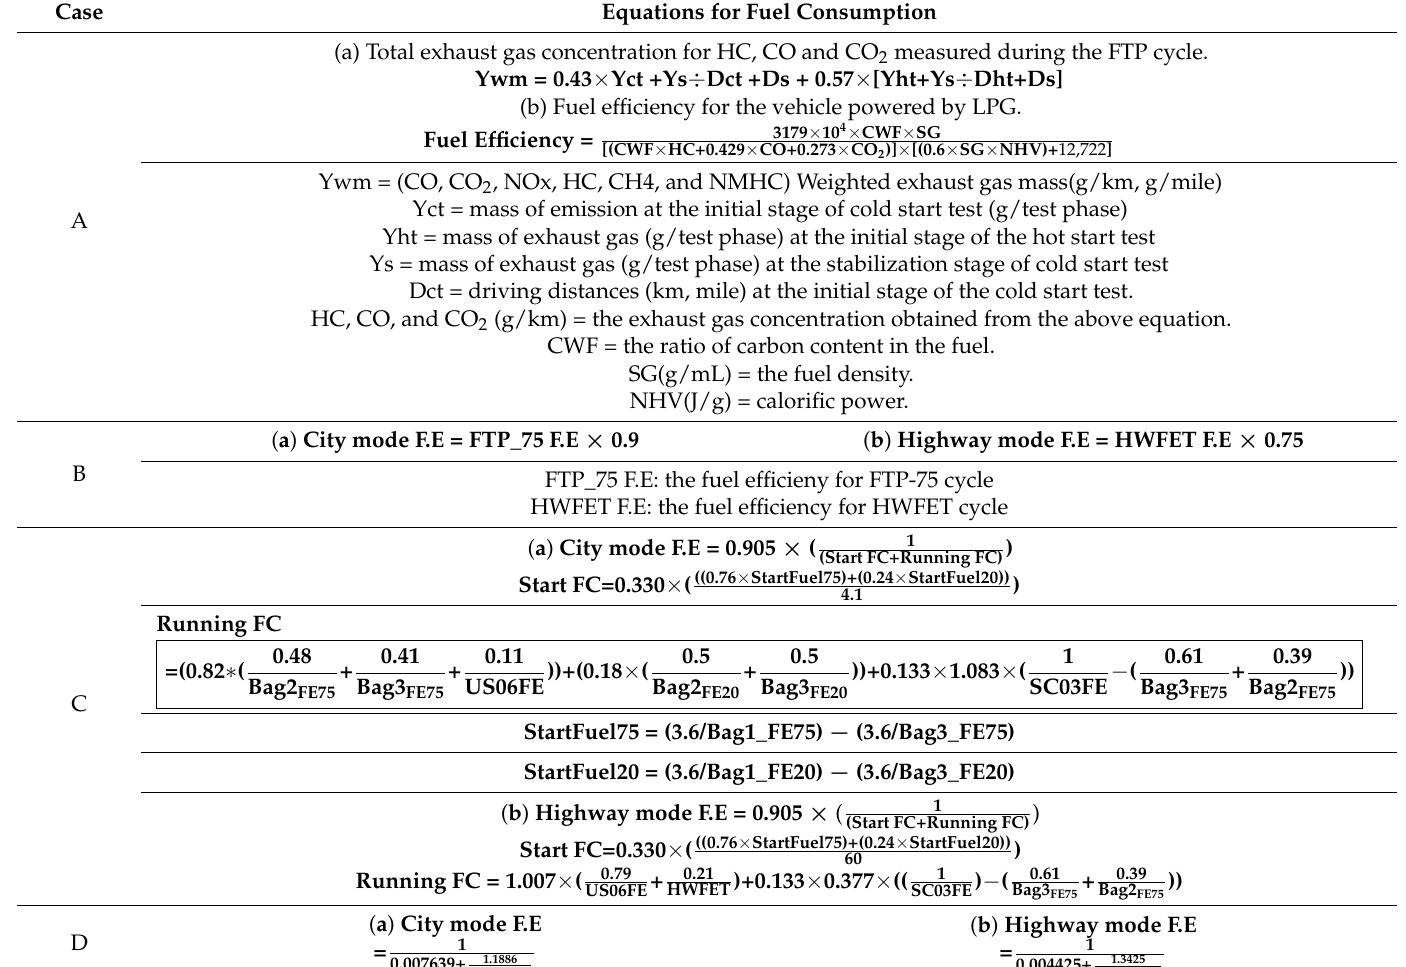
Table 3. One unadjusted and three adjusted fuel consumption